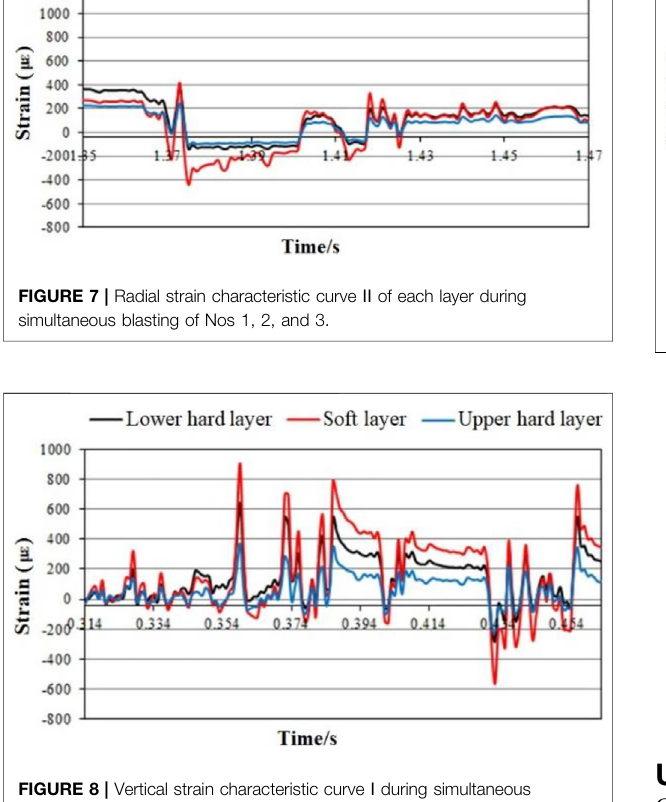
Frontiers in Energy Research |